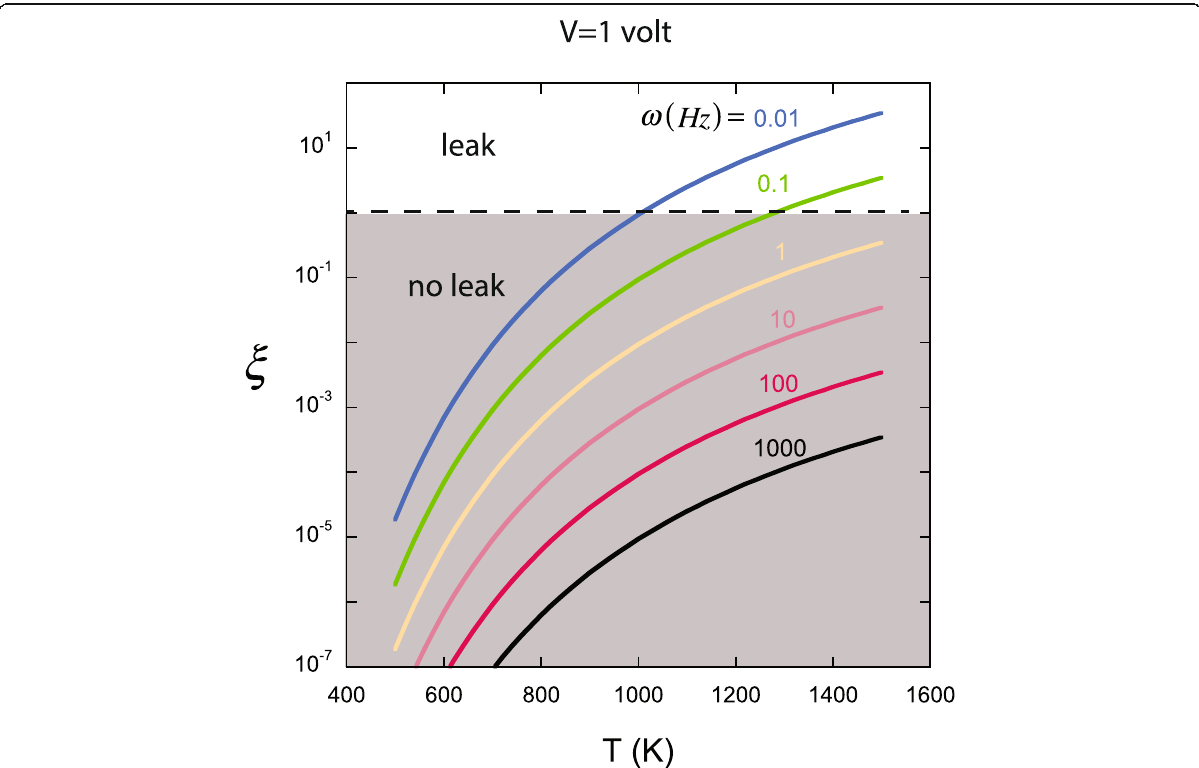
Fig. 2 A figure showing the conditions where hydrogen loss caused by the migration of hydrogen (protons) to the electrode. The degree of hydrogen loss can be characterized by a non-dimensional parameter, ξ ð ≡ l field, d is the thickness of the specimen). If ξ ≥ 1, substantial hydrogen loss will occur, whereas if ξ ≪ 1, hydrogen loss is not important. This factor is highly sensitive to the (lowest) frequency and the voltage used. Using high frequencies and/or low voltage, the hydrogen loss can be